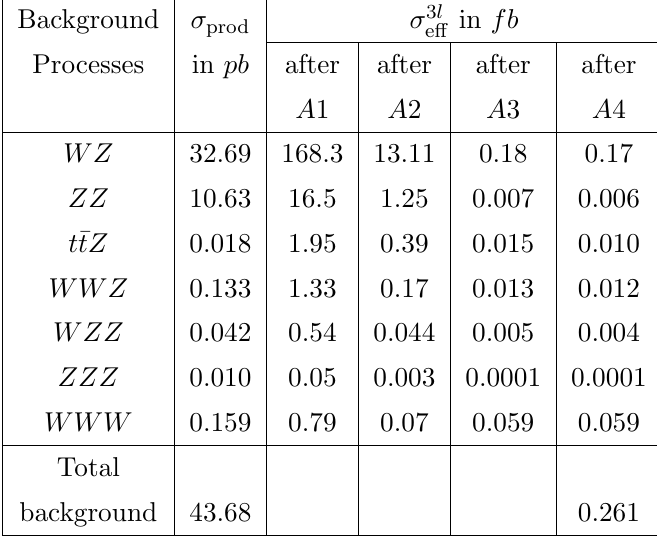
) after all cuts of di(cid:11)erent SM back- e(cid:11)